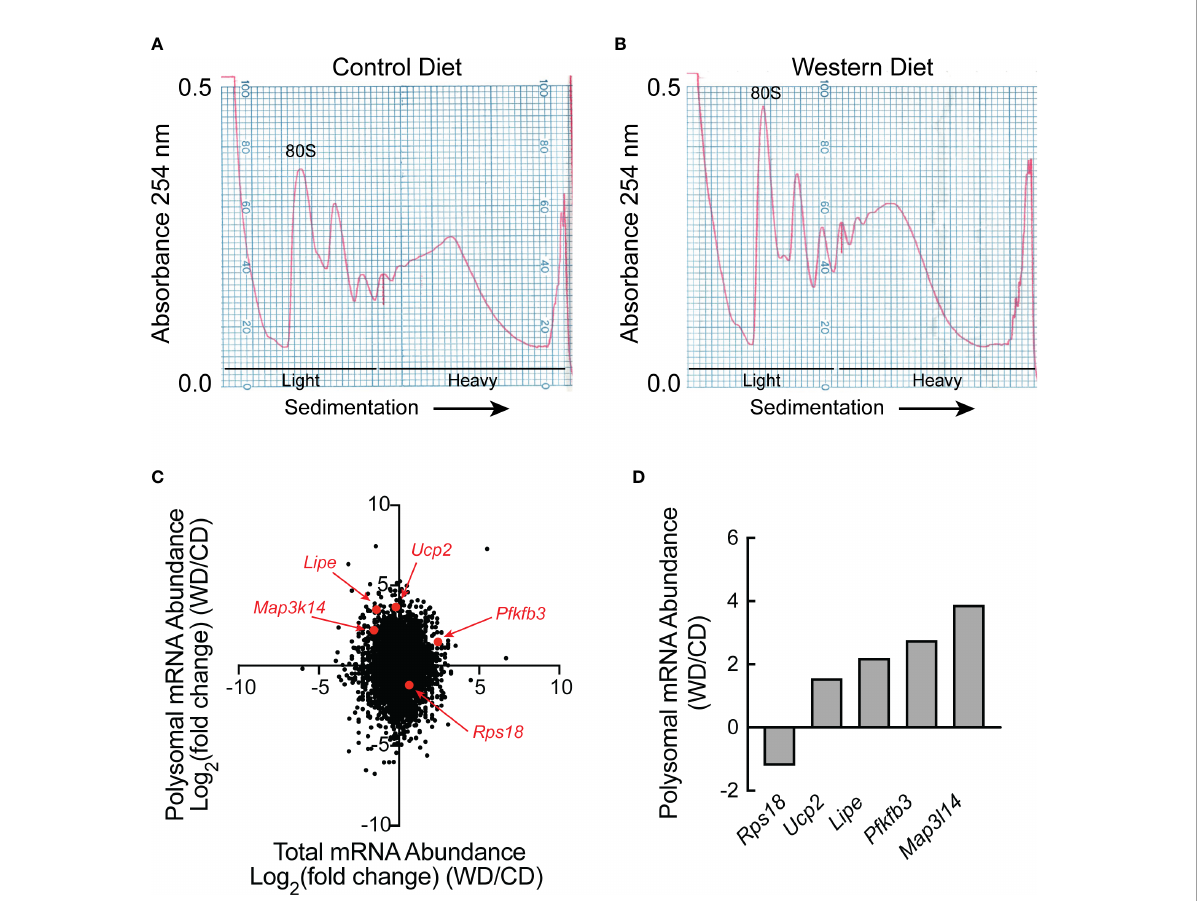
FIGURE 2 RNAseq and Riboseq analysis of livers of rats fed either a control diet or Western diet. Representative sucrose density gradient pro fi les from the liver of rats fed either a (A) control diet or (B) Western diet for 2 weeks. (C) Western diet-induced changes in mRNA abundance (x-axis) and the proportion of mRNA in the heavy vs the light polysomal fraction from the sucrose density gradients (y-axis) as assessed by RNAseq and polysome pro fi ling analysis, respectively. For this analysis, equal amounts of RNA from three rats/condition were pooled for RNAseq analysis, and equal amounts of RNA from the sucrose density gradient fractions of three rats/condition were pooled for polysome pro fi ling. (D) qRT-PCR analysis of RNA isolated from the heavy and light fractions from the sucrose density